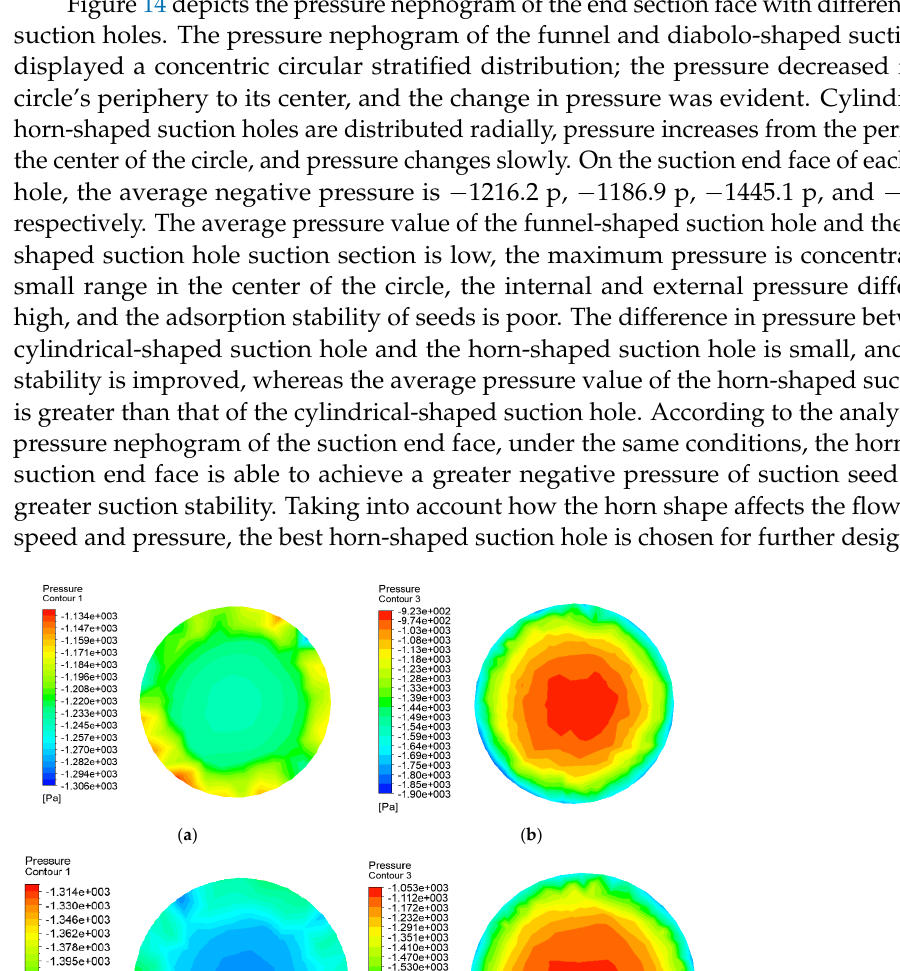
Figure 13. Velocity vector diagram of the suction hole section. a ) Cylindrical-shaped suction hole; ( b ) Funnel-shaped suction hole; ( c ) Horn-shaped suction hole; ( d ) Diabolo-shaped suction hole.